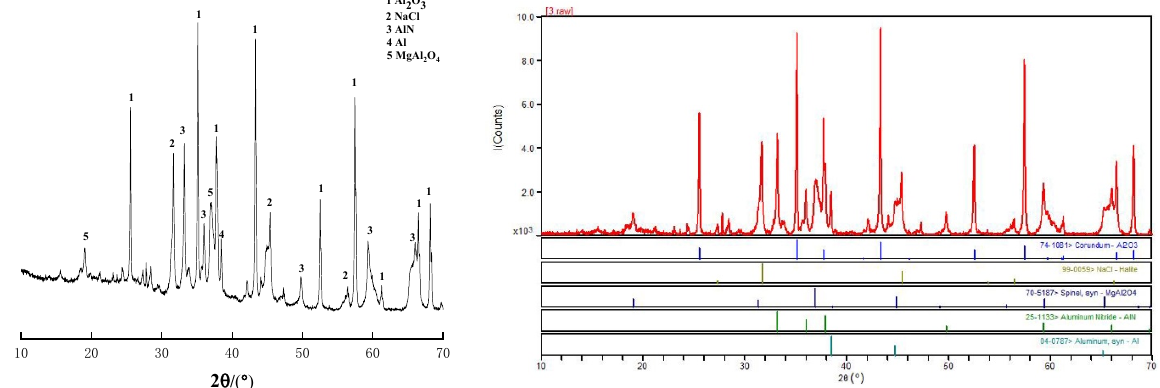
Figure 1. XRD pattern of the raw material.